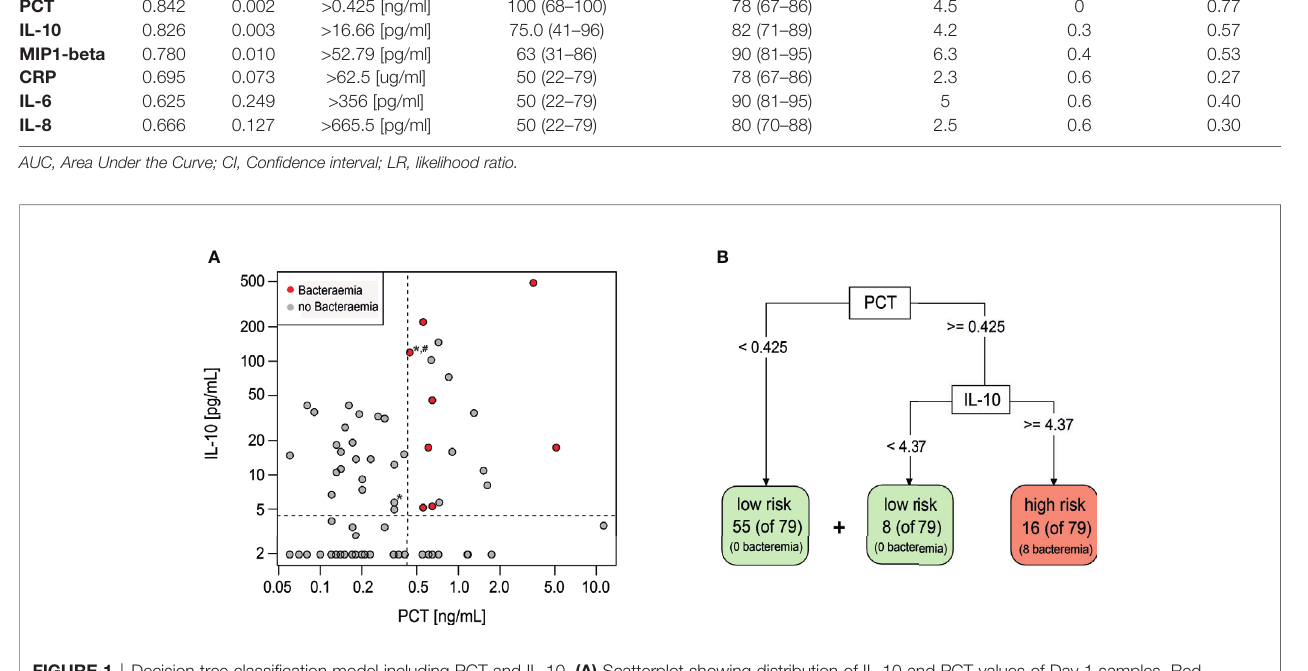
FIGURE 1 | Decision tree classi fi cation model including PCT and IL-10. (A) Scatterplot showing distribution of IL-10 and PCT values of Day 1 samples. Red- bacteraemia cases, grey-no bacteraemia. (*) depicts ICU admission, (#) depicts severe sepsis diagnosis. (B) Decision tree model to identify low risk and high risk episodes using PCT and IL-10 with the indicated threshold values.